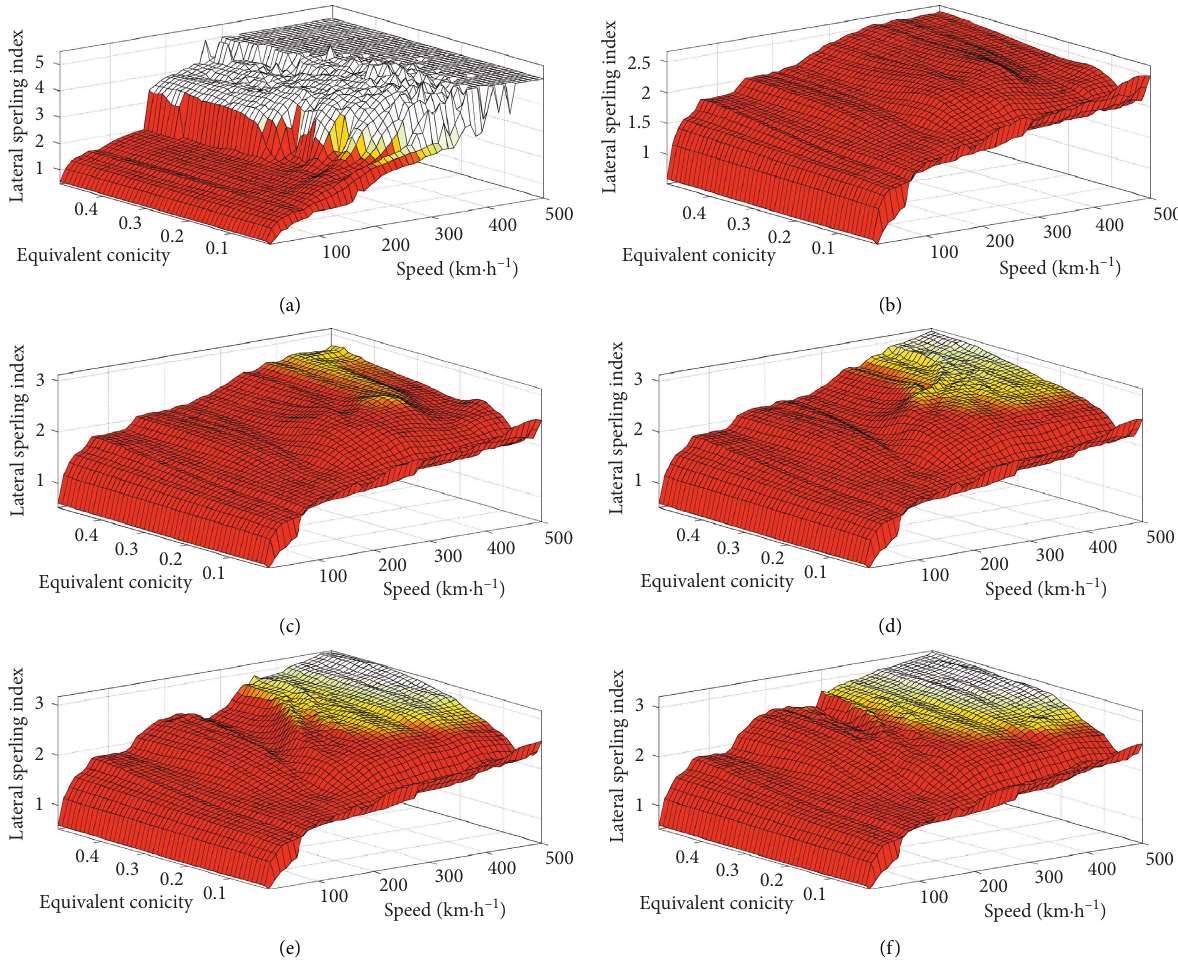
Figure 13: Vehicle ride quality space with joint stiffness of 70MN · m − 1 and additional stiffness of 4MN · m − 1 . (a) c � 0. (b) c � 110 kN · s · mm − 1